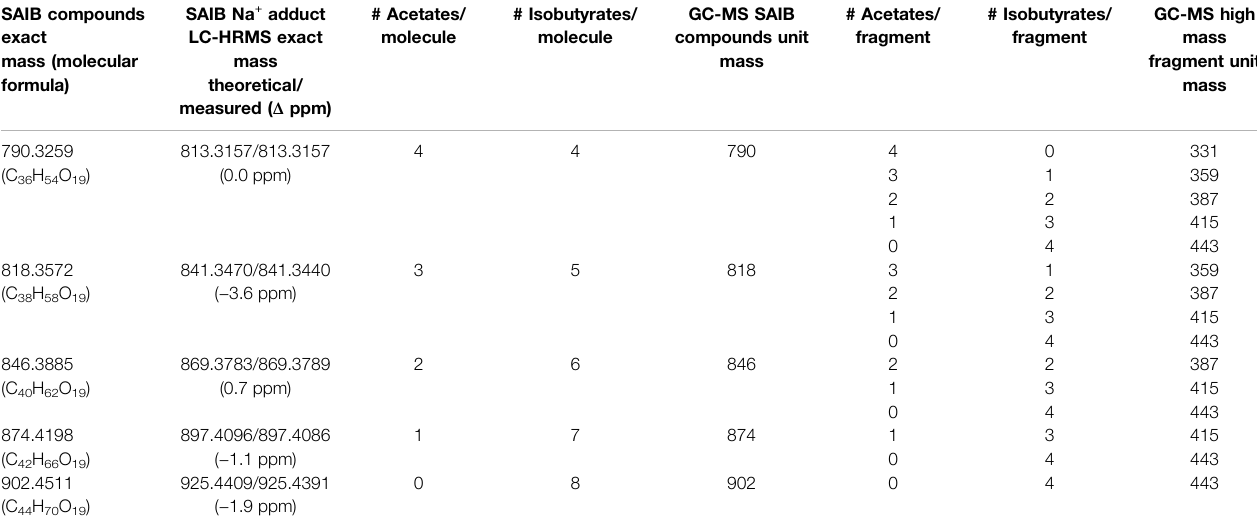
MolecularionsfortheSAIBcompoundsarenotobservedinEIGC-MSanalysis,butthehighmassionfragmentscorrespondingtothevarioustetraesterdistributionsontheglucoseand fructose fragments are observed. See text for discussion.